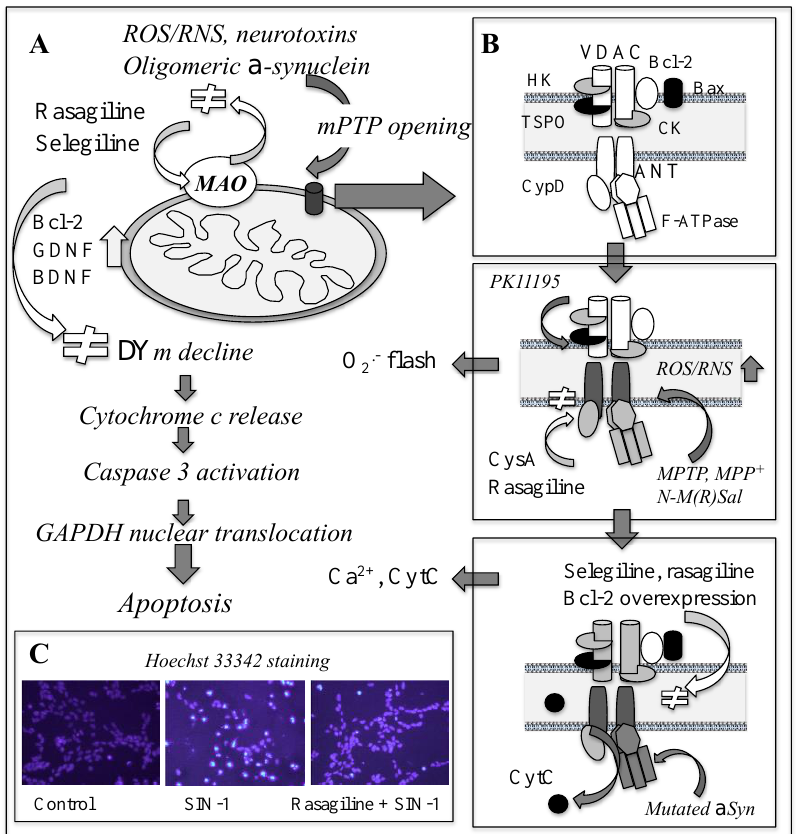
Figure 3. Apoptosis process and inhibition by rasagiline and selegiline. ( A ). ROS/RNS and neurotoxins induce the mPTP opening and stepwise activation of apoptosis, which rasagiline and selegiline completely prevent. Mutated αSyn binds to and inhibits ATP synthase and opens the mPTP. ( B ). Modulation of the mPTP formation by rasagiline and selegiline. PK11195, a TSPO ligand, opens a pore composed of ANT and CypD at the IMM, shown as superoxide flash, which CysA and rasagiline prevent. Then, the mPTP open with Ca 2+ release occurs, which Bcl-2 and selegiline suppress. ( C ) Nu- clear condensation induced by ONOO − -generating SI N -1 in SH-SY5Y cells. Rasagiline inhibits the nuclear condensation visualized by Hoechst 33342